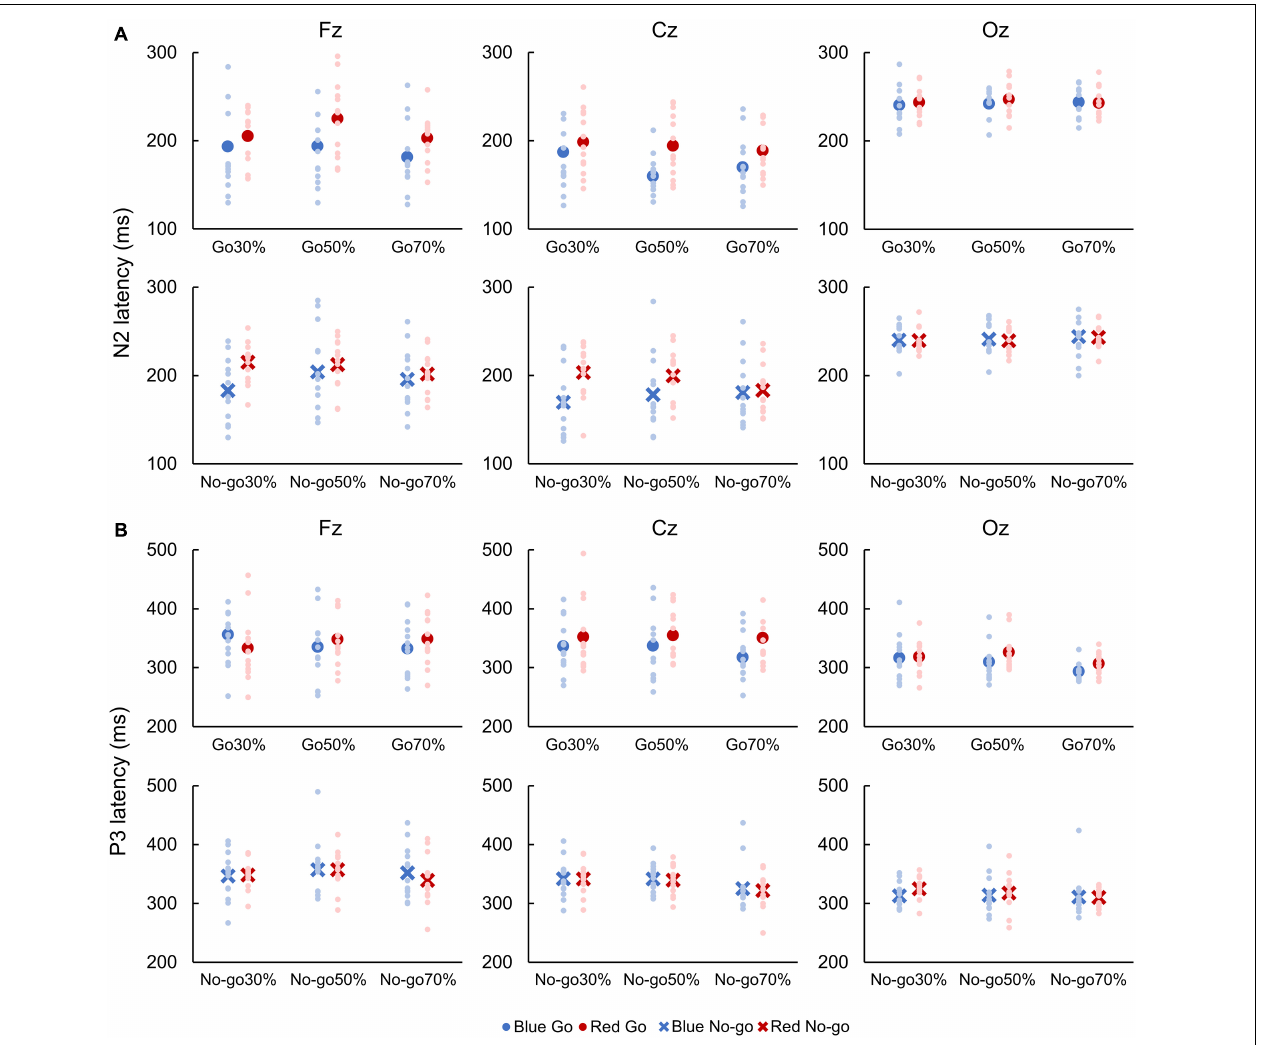
FIGURE 5 | Latencies of N2 (A) and P3 (B) . Blue color indicates responses to a blue light (Blue Go and Blue No-go), and red color indicates responses to a red light (Red Go and Red No-go). Individual data (light color) and their mean (dark color) were presented for each condition.